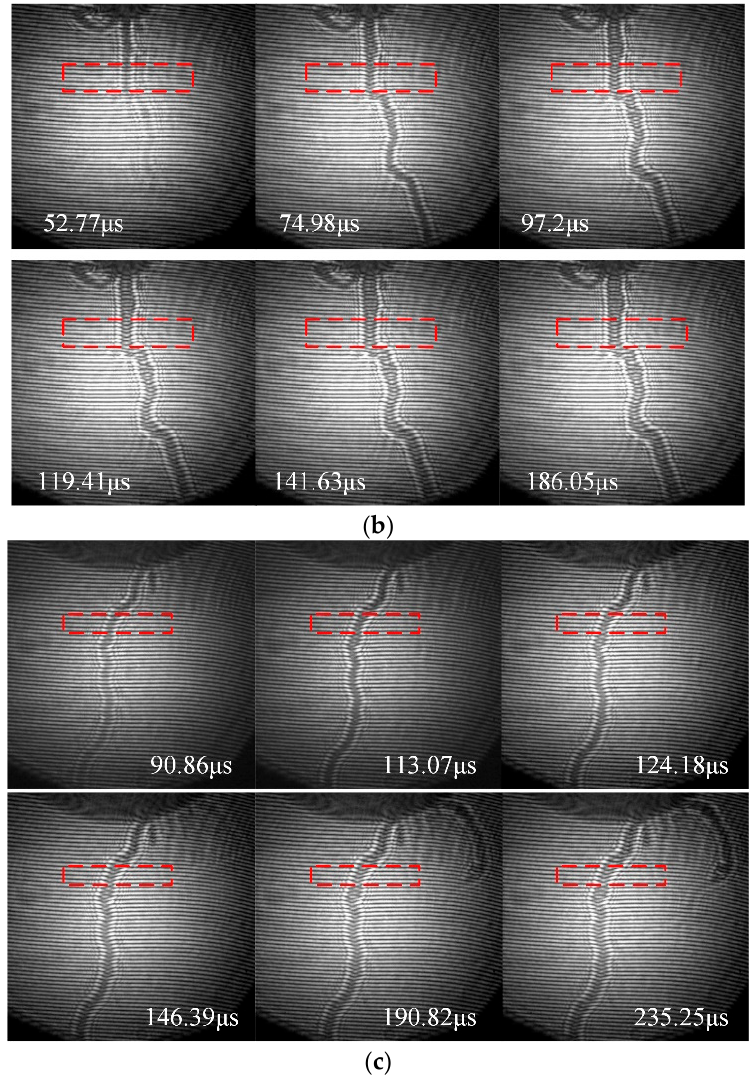
Figure 6. Interference images: ( a ) cone terminal, radius of curvature = 2.5 mm; ( b ) cone terminal, radius of curvature = 5 mm; ( c ) spherical terminal, diameter = 40 mm.